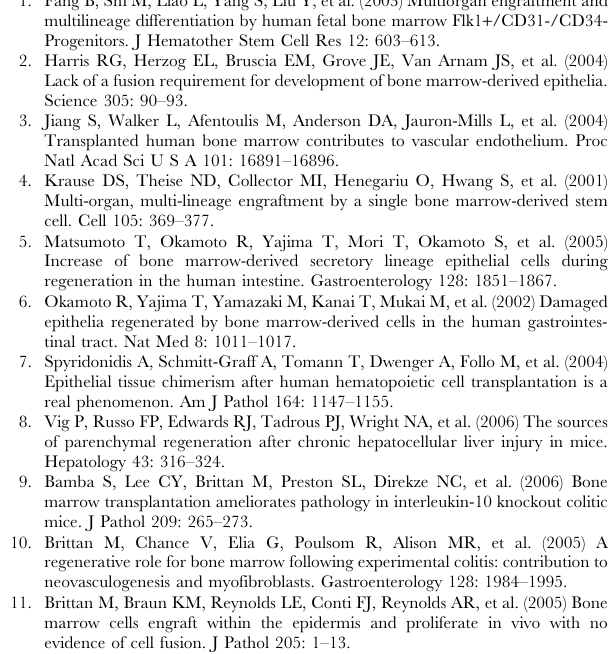
Table S2 The table shows the on-screen measurements (centimetres) between 2 points on paired Photoshop tiff images taken before and after FISH, and their ratios. Slides were taken from all experimental groups. The measure- ments show a very slight shrinkage after the FISH protocol. The points were taken from 3 DAB-stained CD45-positive cells per image, and which were approximately at right angles to each other, in order to estimate the distortion in the X and Y axes. These cells could be easily identified in both images before and after FISH. These changes were not found to alter the assigning of the Y chromosome nuclear signals to the overlay image from the previous IHC staining. In all cases, the alignment of images was performed before the Y signal channel was turned on, to obviate